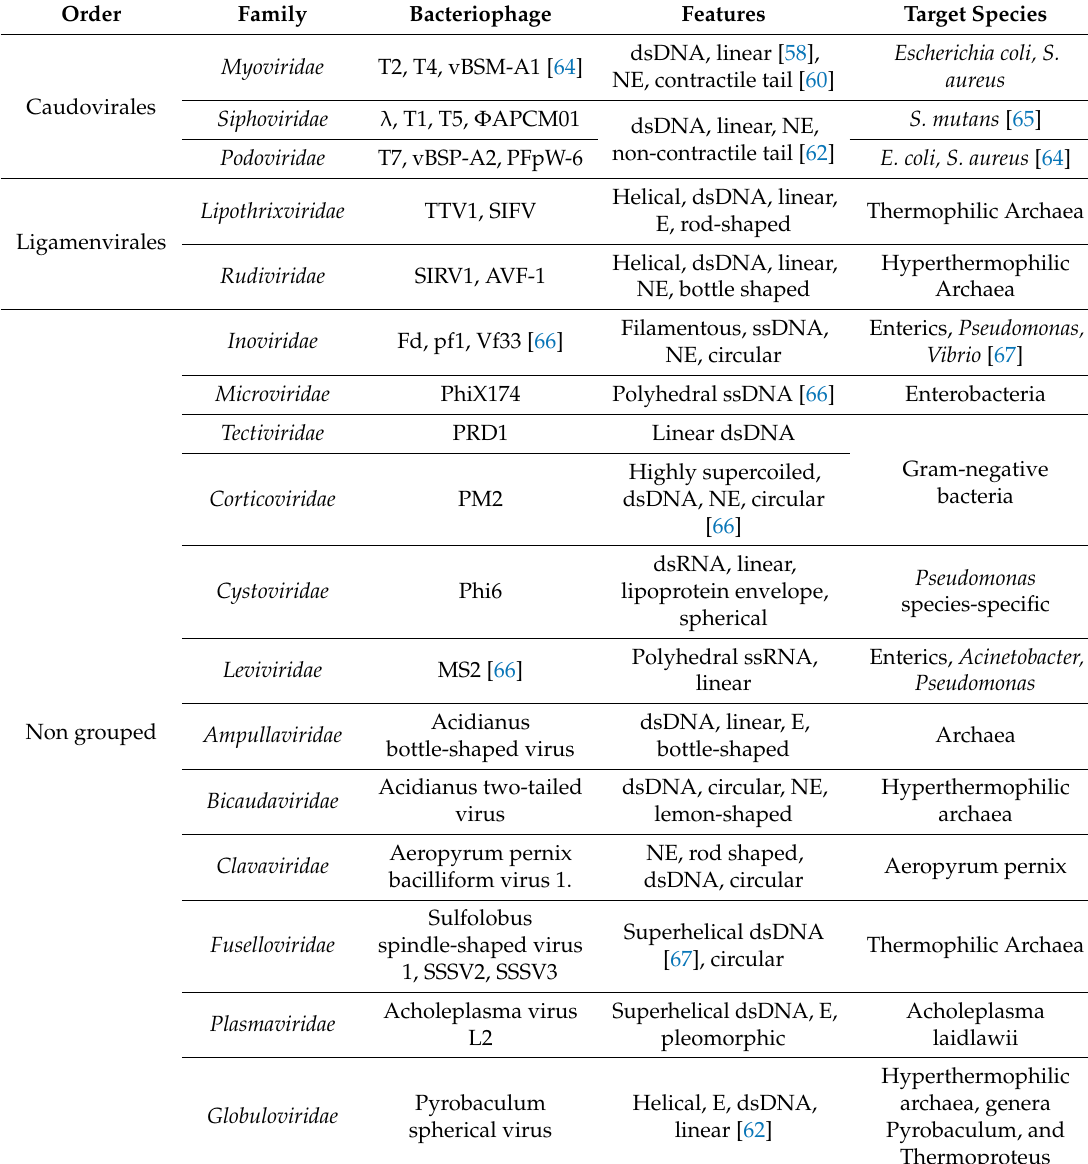
Table 2. Virus order, family, viral examples, features, target species, and related